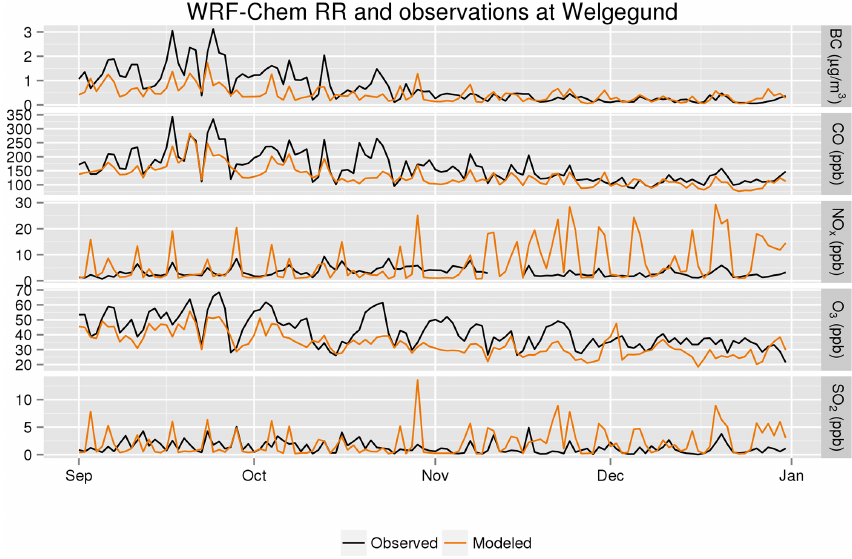
Figure 7. Comparison of modeled daily means of BC and gaseous species with station measurements at